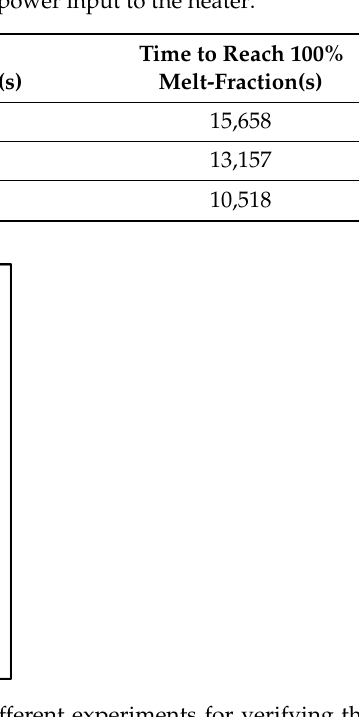
Figure 8. Comparison of temperature profiles in two different experiments for verifying the repeatability of the experiments: for the thermocouples mounted at the location corresponding to the height of the liquid meniscus for PCM melt-fraction of 30% and for heater input power of 1.6 W (2.8 V input).